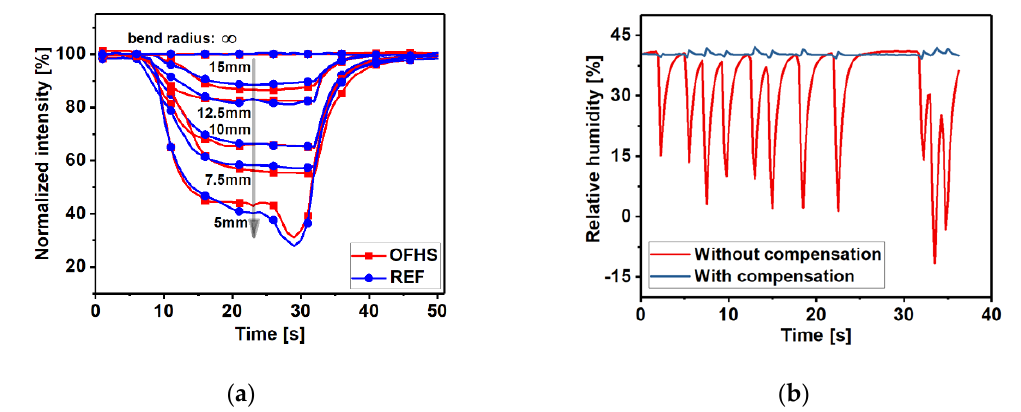
Figure 6. ( a ) The response from OFHS and REF fibre during bending over a range of bend radius (up to 5mm). ( b ) The output from the sensing probe during random bending. The red trace is the RH output without compensation from the reference fibre and the dark blue trace is after compensation.